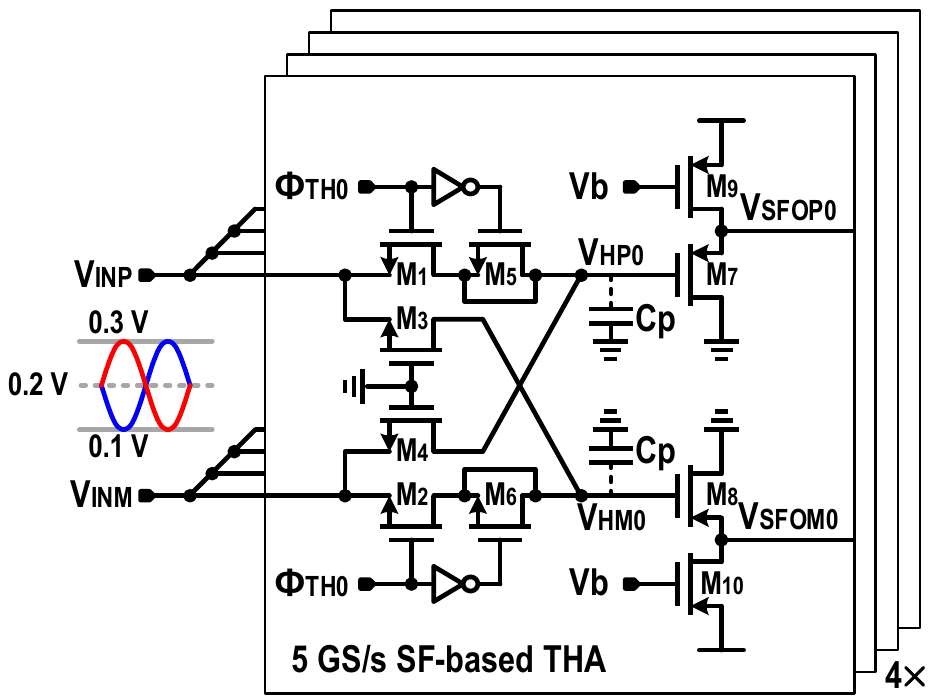
Figure 2. Input network of the proposed 20 GS/s TI ADC composed of 4-channel 5 GS/s SF-based THAs.